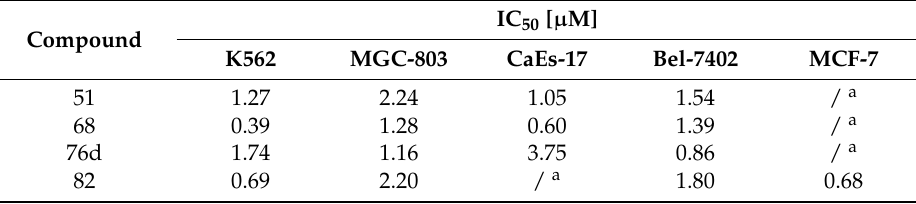
Table 1. The most potent spirolactone-type diterpenoid derivatives of each series. Compound K562